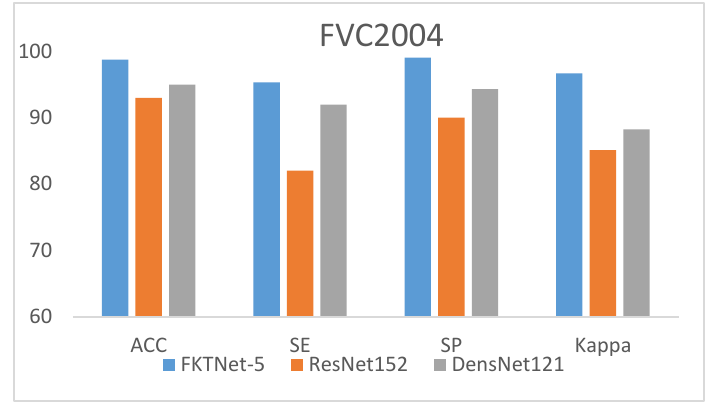
Figure 6. Comparison between FKTNET-5 and pre-trained ResNet-152 and DensNet-121 on FVC2004 dataset (four classes).